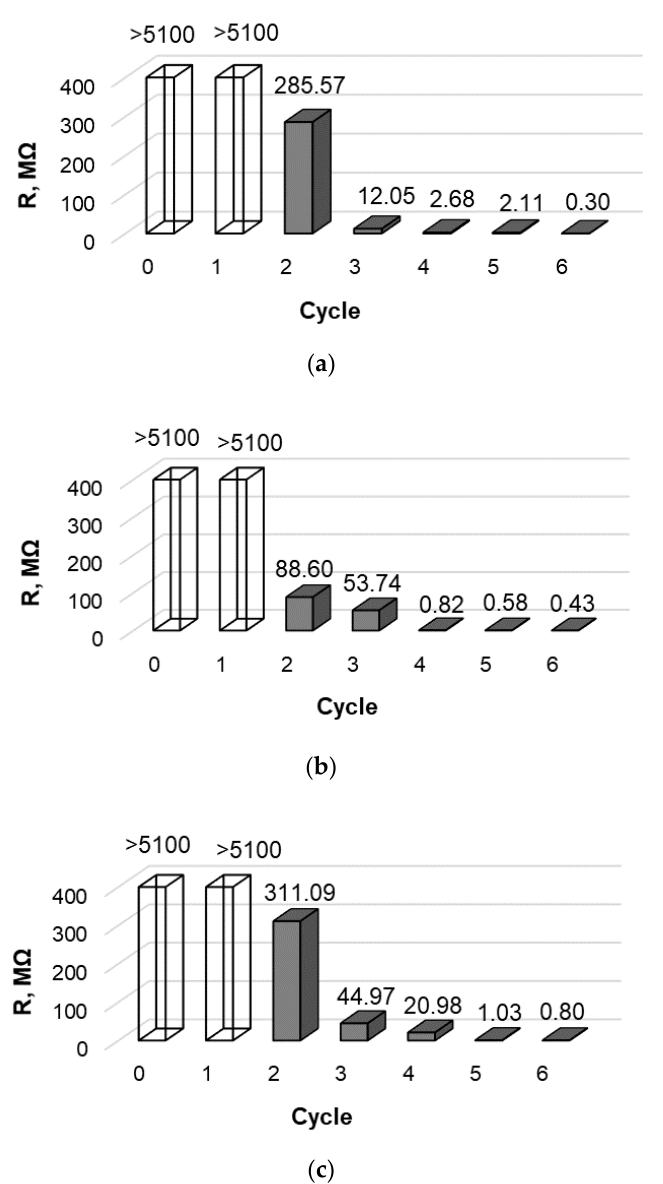
Figure 5. Distribution of resistance measurement with synthetic fibers: ( a ) PA6, ( b ) PA66, and ( c ) PAN.